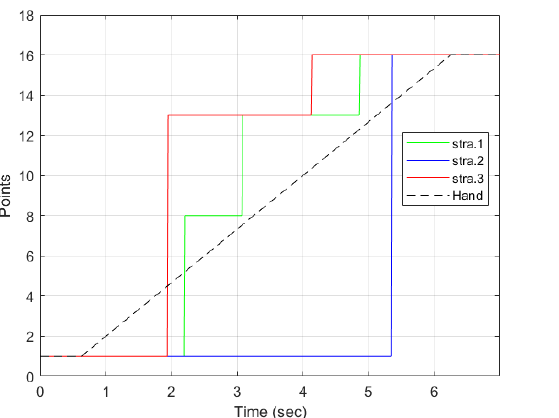
Figure 11. Comparison of the strategies for the trajectory from P 1 to P 16 . The dotted line indicates the time the hand is at the start and the target